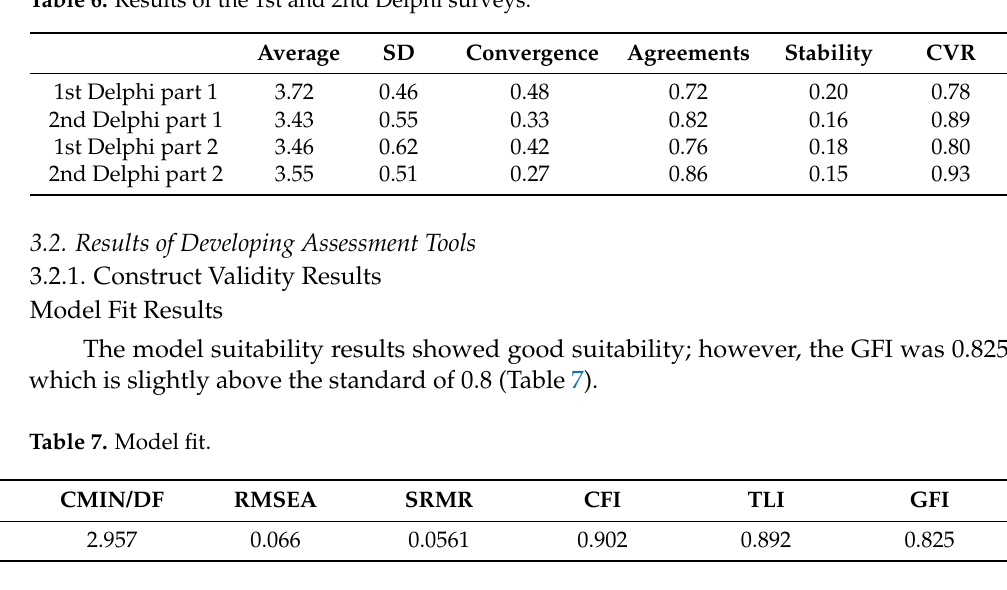
Table 6. Results of the 1st and 2nd Delphi